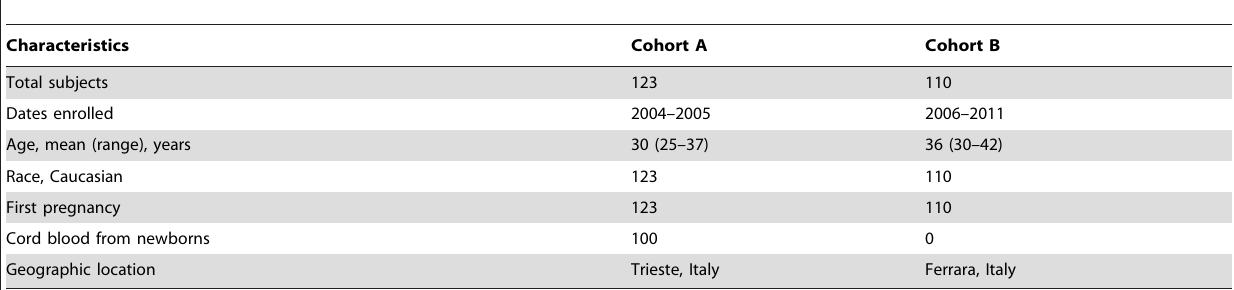
Table 1. Demographic characteristics of pregnant women in Italy analyzed for SV40